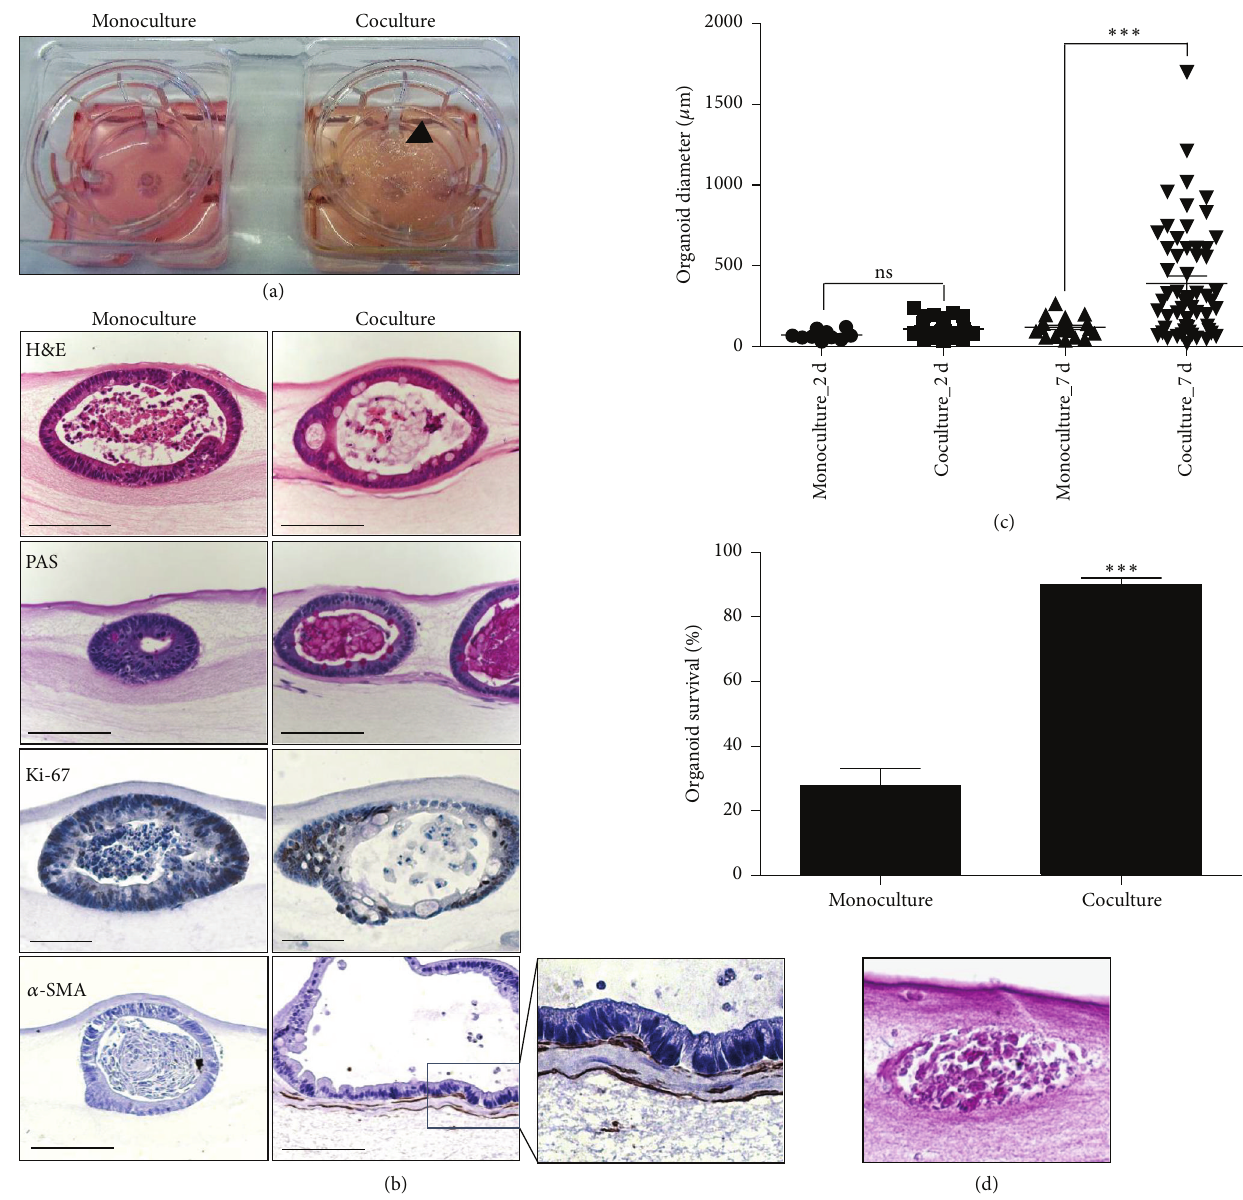
Figure 3: Fibroblasts improve organoid growth and organoid culture survival. (a) Macroscopic image of the crypt monoculture and coculture in an organotypic cell culture system at day 7. (b) Characterization of the crypt monoculture (left panel) and coculture (right panel) in an organotypic cell culture system at day 7 by immunohistochemistry staining: H&E (scale bar 100 𝜇 m), PAS (scale bar 100 𝜇 m), Ki-67 (scale bar 50 𝜇 m), and 𝛼 -SMA staining (scale bar 100 𝜇 m), with adjacent magnification. (c) Organoid diameter measured on H&E slides from crypt monoculture and coculture in organotypic cell culture system after 2 and 7 days of culture. Each dot represents a single organoid. 𝑃 < 0.0001 (one-way ANOVA with Bonferroni comparison). (d) Lower, example of a nonviable crypt in organotypic cell culture system, H&E staining. Scale bar, 25 𝜇 m. Upper, survival of crypts in an organotypic cell culture system, for the monoculture 169 crypts were quantified; for the coculture 213 crypts were quantified. 𝑃 < 0.0001 , two-tailed 𝑡